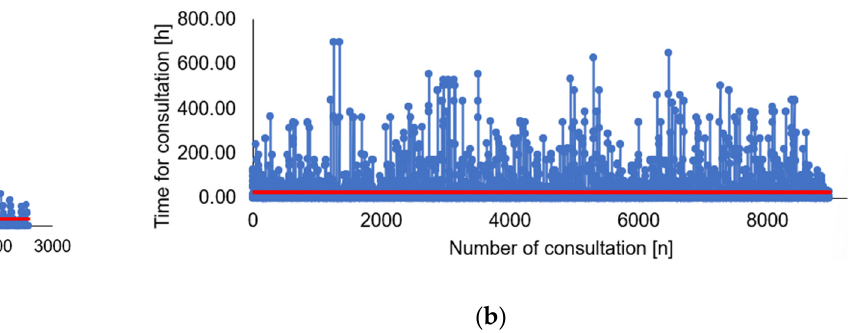
Figure 4. Process flow chart: ( a ) before Lean intervention; ( b ) after Lean intervention. The X-axis shows the numbers of consultations. The Y-axis shows the time to complete consultation. Average waiting time for consultations is reported in red (solid line).